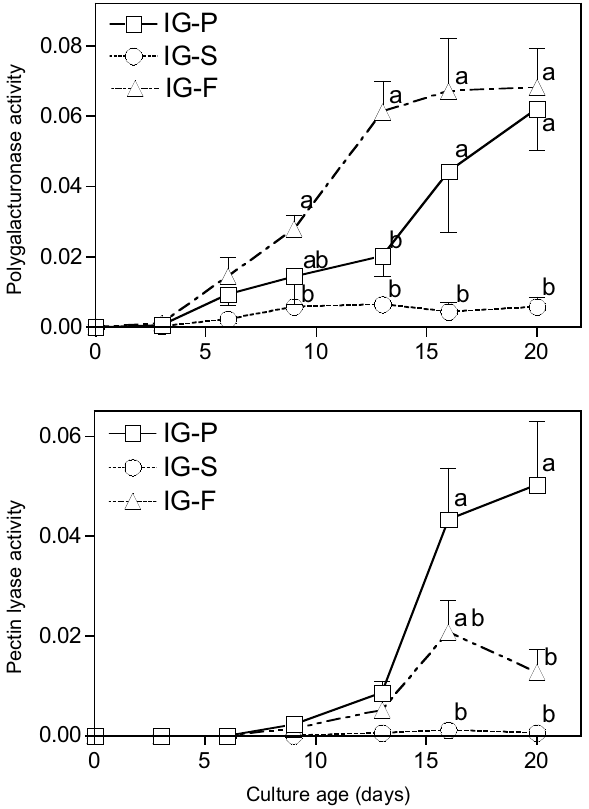
Fig. 2. Time-course determination of polygalacturonase and pectin lyase activities produced by the intersterile groups (IGs) P (- (cid:1) -), S (- (cid:2) -) and F (- (cid:1) -) of Heterobasi- dion annosum grown in liquid nutrient medium with 1% pectin as the sole carbon source. Polygalacturonase activity is expressed as µ moles of galacturonic equiva- lents min -1 ; pectin lyase activity as µ moles of unsatu- rated uronides min -1 . Values are means of 9 isolates of IG-P and IG-S and 8 isolates of IG-F; bars represent SE. Means followed by the same letter at each incuba- tion time do not significantly differ at P =0.05, accord- ing to Tukey’s test; the absence of letters indicates no significant difference among the